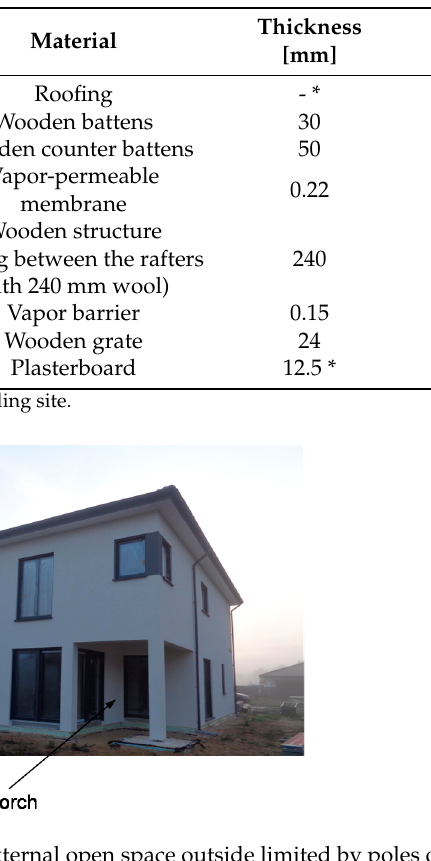
Figure 3. Porch—external open space outside limited by poles or pillars (Silesia, Poland).